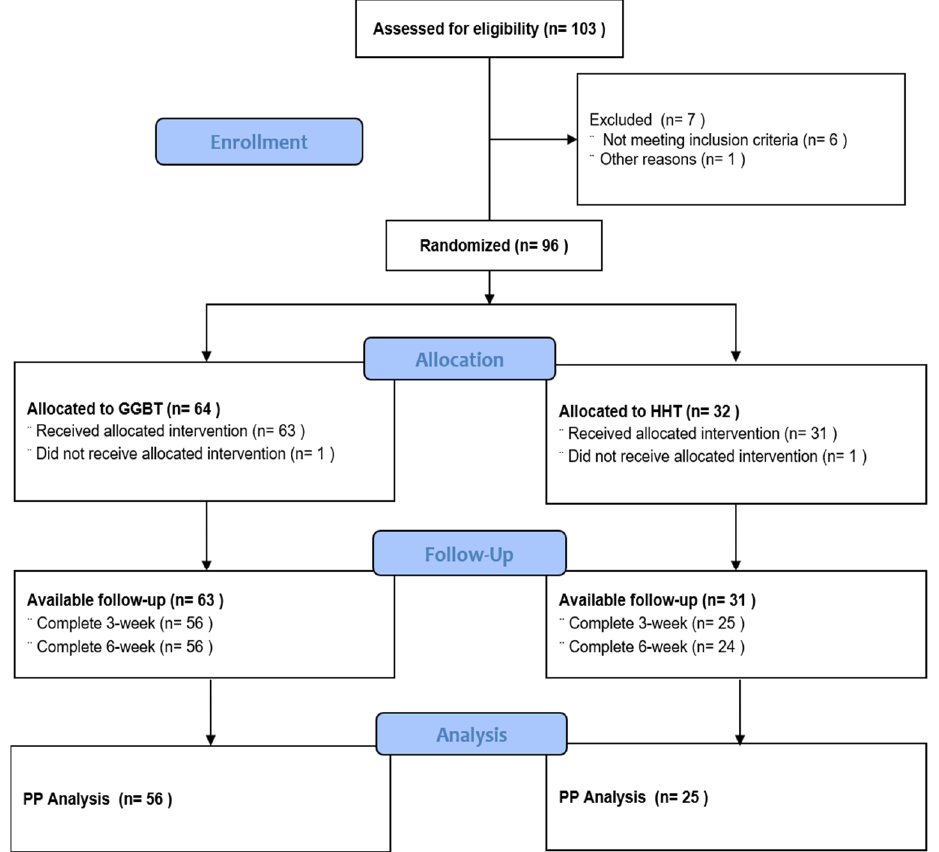
Figure 1. The CONSORT flowchart of study process. Table 1. Baseline characteristics for participants.